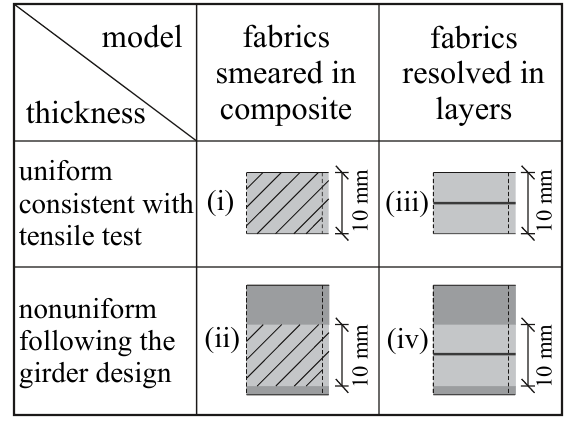
Figure 18. Studied types of cross-sectional representations